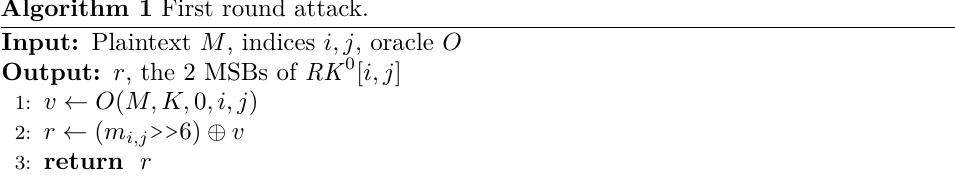
Algorithm 1 First round attack.